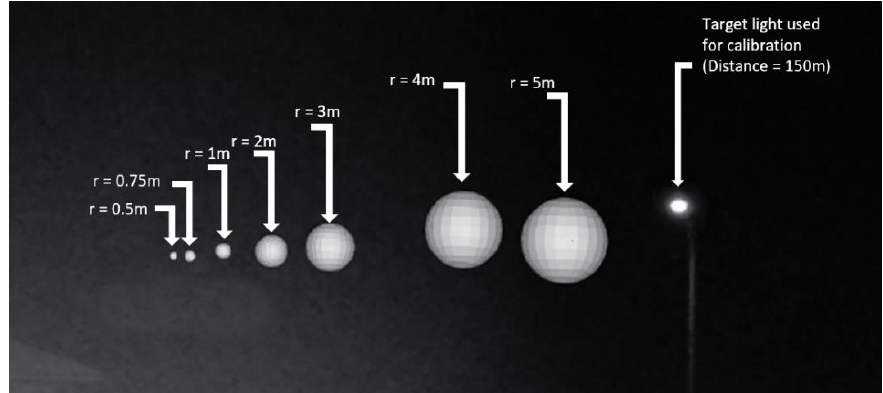
Figure 3. Projected view of fishing boat at AMC Surface Vessel Bluefin at angle of 75.6°.